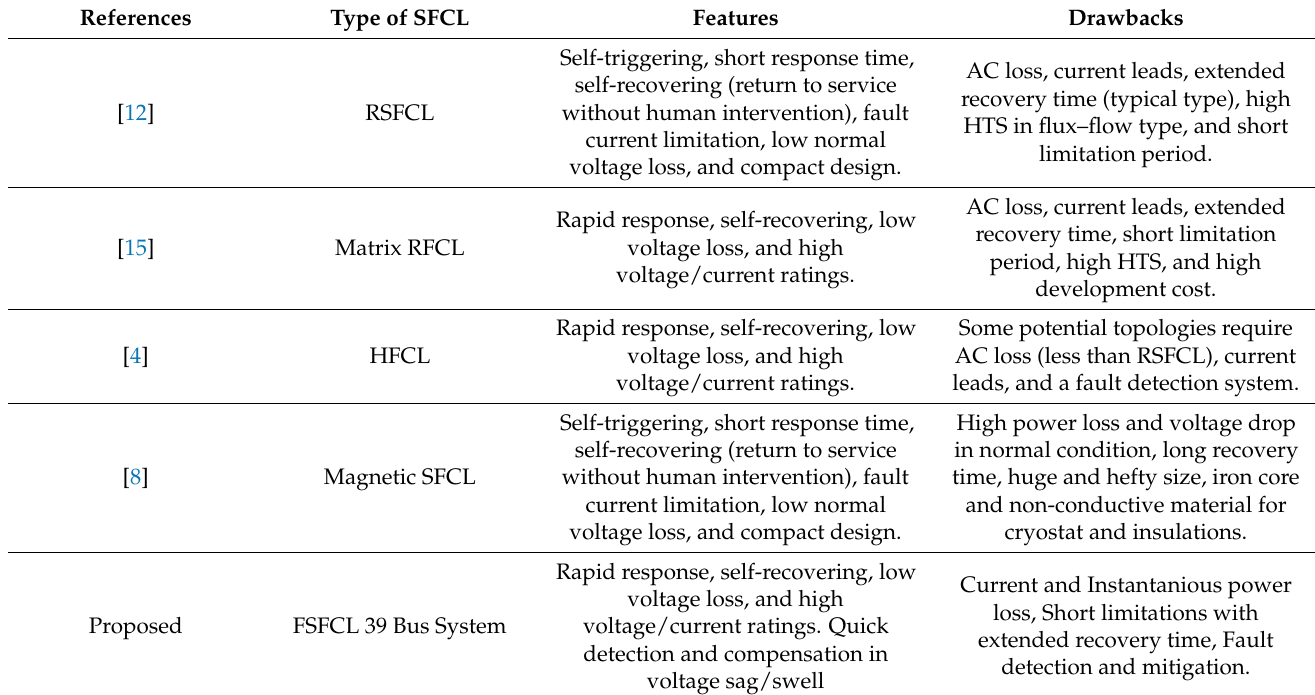
Table 1. The comparative analysis of current study with previous state-of-the-art